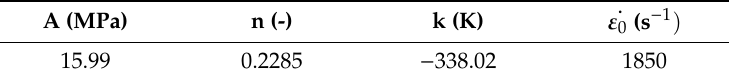
Table 12. Perfect plasticity model parameter.